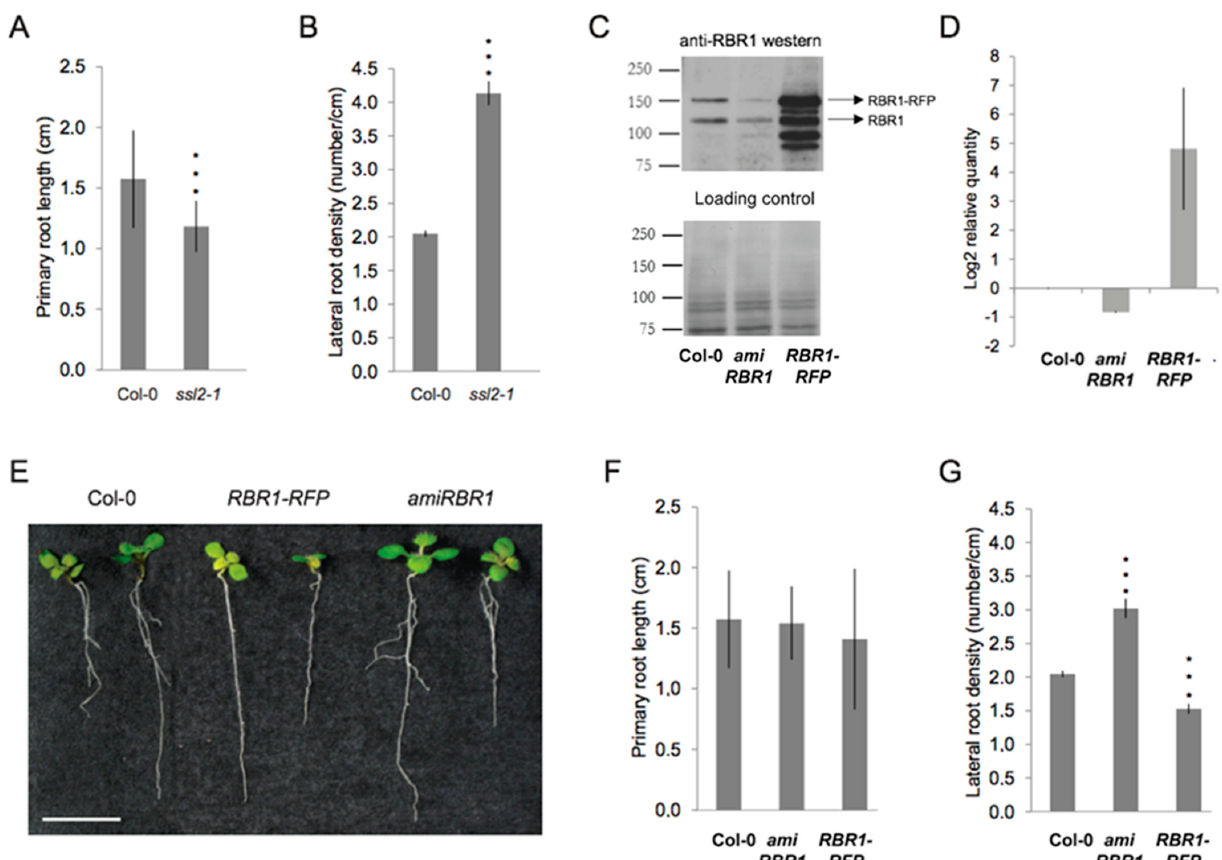
Figure 3. RBR1 protein abundance affects lateral root development. ( A , B ) Phenotypic analysis of 10 DAG ssl2-1 roots. Quantification of the primary root length ( A ) and the lateral root density ( B ) in 10 DAG Col-0 and ssl2-1 line. Error bars represent means ± SD of the mean. The data were normalized to the levels in Col-0, p < 0.001 by two-sided t -test; n Col-0 = 57, n ssl2-1 = 41. ( C ) Western blot analysis of RBR1 protein level and ( D ) quantitative real time RT-PCR (qRT-PCR) analysis of RBR1 mRNA expression in wild-type Columbia (Col-0), amiRBR1 and pRBR1::RBR1-RFP ( RBR1-RFP ) lines. The expression level of RBR1 was normalized to At1g61670 and At3g03210 (mean stability value M = 0.0405), and data (log2) from three technical replicates are shown as means ± standard deviation (SD). ( E ) Phenotype of 10 DAG seedlings expressing different levels of RBR1. Bar = 1 cm. ( F ) Quantification of the primary root length (cm) and ( G ) the lateral root density in 10 DAG Col-0, amiRBR1 and RBR1-RFP roots. Error bars represent means ± SD of the mean. The data were normalized to the levels in Col-0, p < 0.001 by two-sided t -test (***); n Col-0 = 57, n amiRBR1 = 50, n RBR1-RFP =